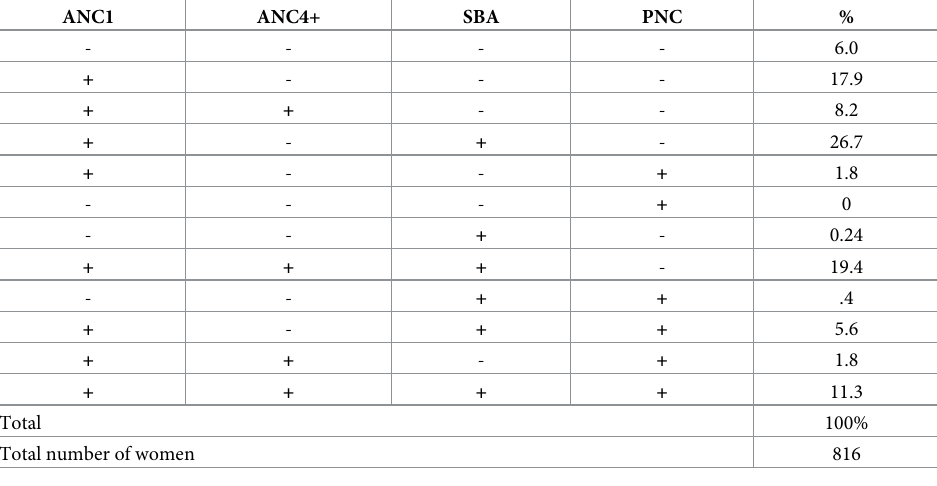
Table 3. Percent distribution of women by different types of maternal health services received for the most recent birth, Hadiya zone 2021.